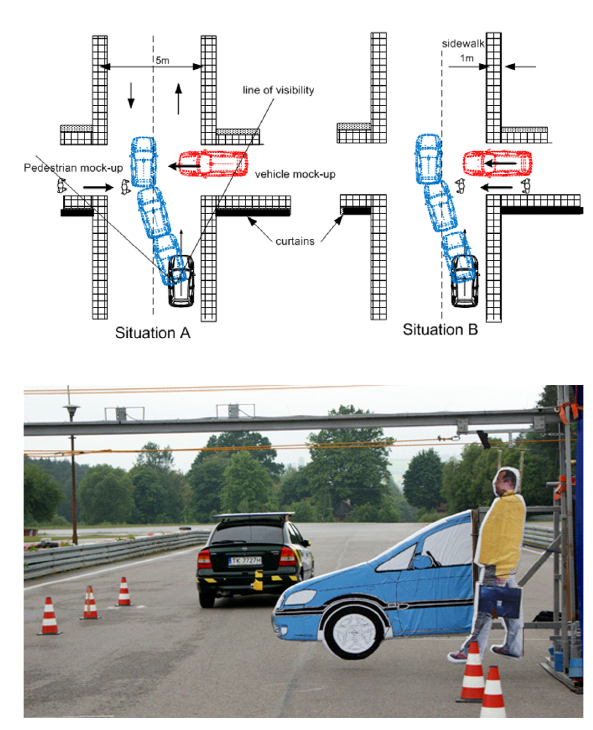
Fig. 6. Diagram of ‘Scenario 5’ and photo from the analysed scenario